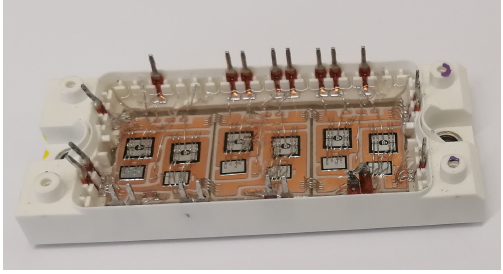
Figure 1. An unpacked IGBT